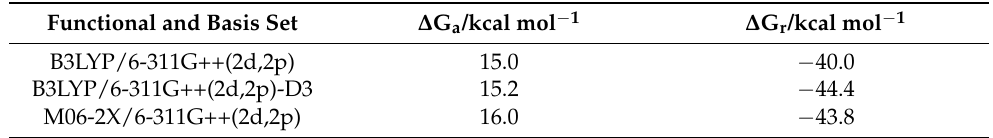
Table 2. The Gibbs free activation and reaction energy obtained through single point calculations with added thermal corrections using three different functionals. Functional and Basis